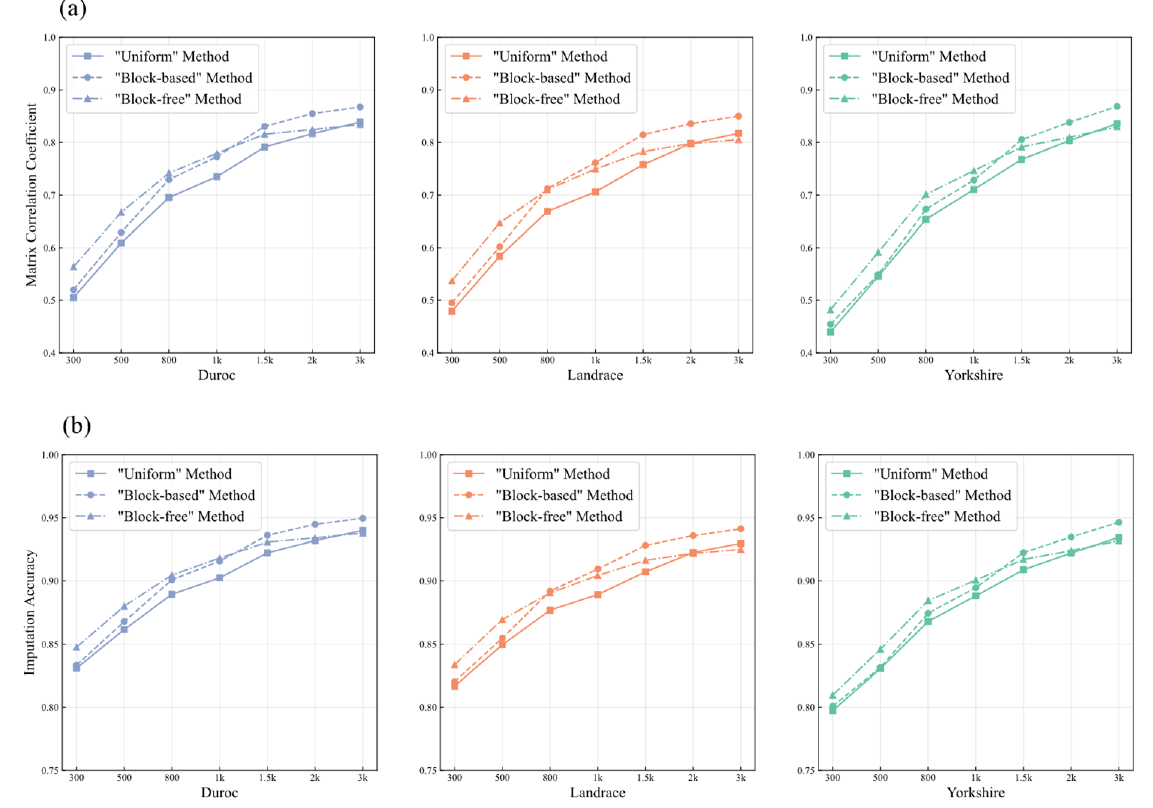
Figure 3. Genotype imputation performance of different low-density panels. The horizontal coordi- nate represented the density of low-density panels, and the vertical coordinate indicated ( a ) genotype imputation accuracies, ( b ) correlation coefficients of the matrices of the imputed and raw genotypes. The shapes of square, circle, and triangle represented the “uniform” method, the “block-based” method, and the “block-free” method, respectively. The colors blue, orange, and green represented Duroc, Landrace, and Yorkshire, respectively.